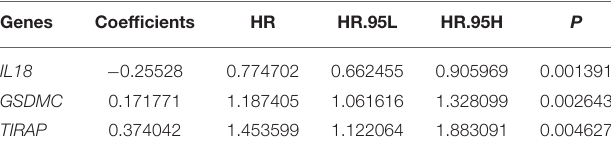
TABLE 1 | Regression coefficients of genes in the prognostic